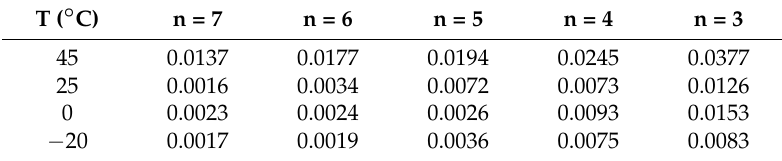
Table 4. RMSE values of polynomial fitting with different orders and different